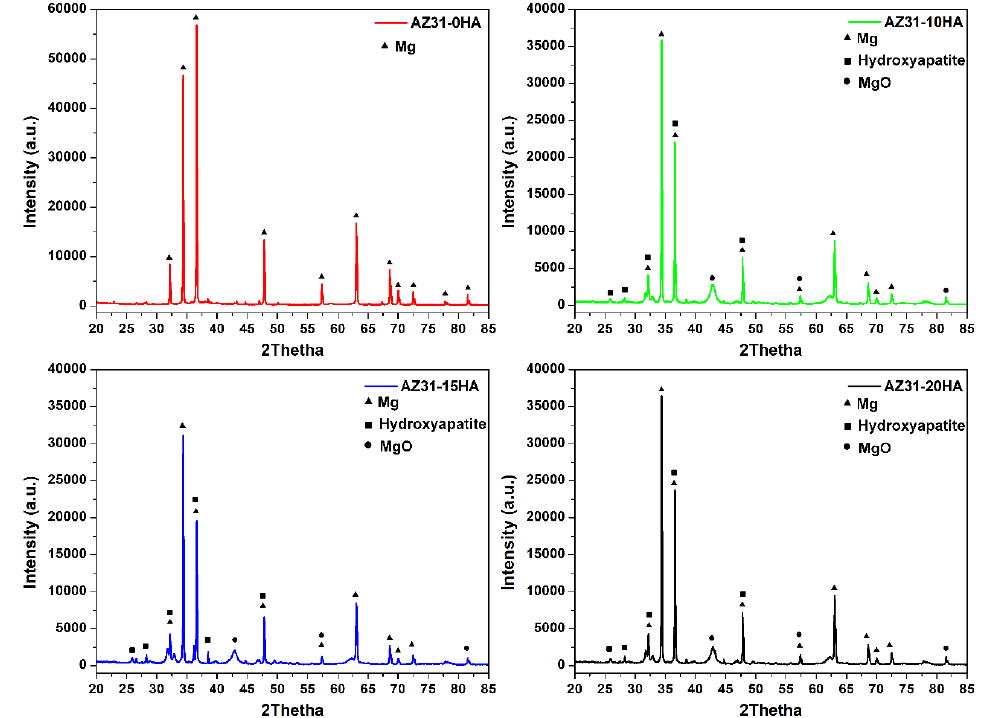
Figure 5. Typical XRD spectra of microwave-sintered AZ31-HA BMMCs.